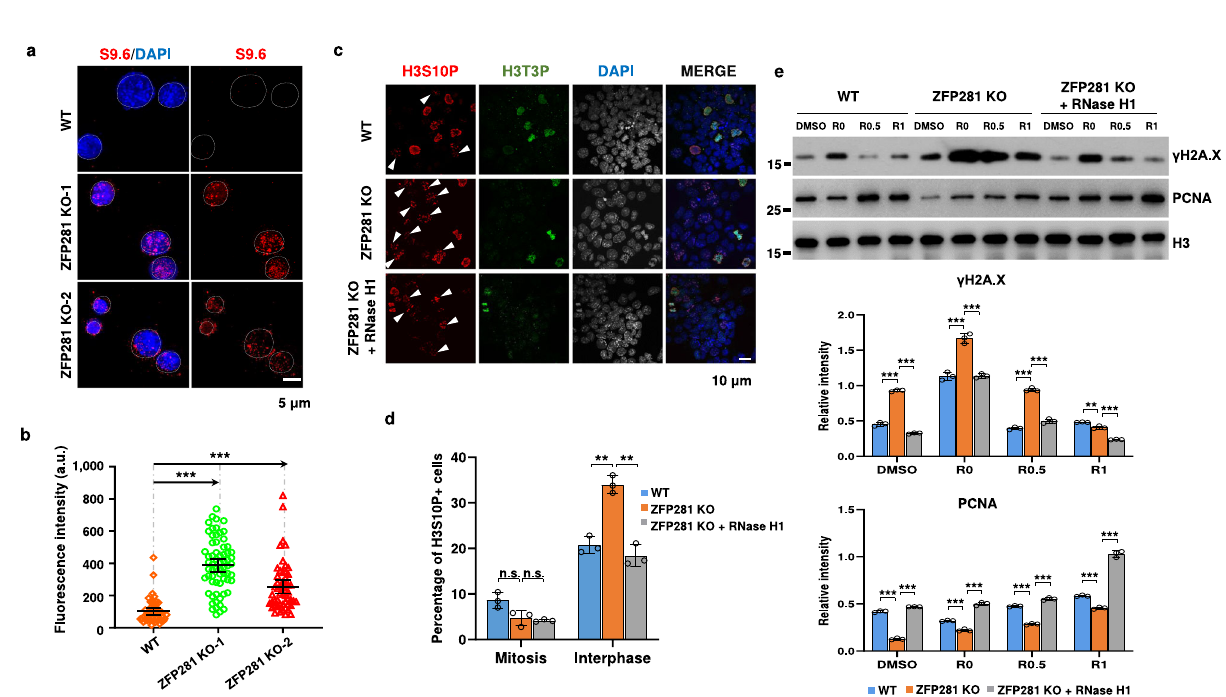
Fig. 3 ZFP281 depletion leads to aberrant R-loop accumulation. a Representative immuno fl uorescence images with the S9.6 antibody showing the levels of R-loop in WT, ZFP281 KO-1, and ZFP281 KO-2 ES cells. DNA was counterstained using DAPI. Three independent experiments show similar results. b Fluorescence intensities of R-loop loci in WT ( n = 48), ZFP281 KO-1 ( n = 66) and ZFP281 KO-2 ( n = 53) ES cells. Three independent experiments show similar results. Error bars represent 95% con fi dence intervals. Two-tailed, unpaired Student ’ s t tests were performed. (WT vs. ZFP281 KO-1, p < 0.0001; WT vs. ZFP281 KO-2, p < 0.0001.) ∗ p < 0.05, ∗∗ p < 0.01, ∗∗∗ p < 0.001, n.s. = not signi fi cant. c Immuno fl uorescence imaging of H3S10P and H3T3P in WT, ZFP281 KO, and ZFP281 KO with RNase H1 overexpression ES cells. White arrows showing the interphase cells positive for H3S10P. d Percentage of WT (total n = 369), ZFP281 KO (total n = 380) and ZFP281 KO with RNase H1 overexpression (total n = 290) ES cells in mitosis and interphase. Mean ± SEM from three independent experiments. Two-tailed, unpaired Student ’ s t tests were performed. (Mitosis, WT vs. ZFP281 KO, p = 0.0574; ZFP281 KO vs. ZFP281 KO + RNase H1, p = 0.5526. Interphase, WT vs. ZFP281 KO, p = 0.0020; ZFP281 KO vs. ZFP281 KO + RNase H1, p = 0.0016.) ∗ p < 0.05, ∗∗ p < 0.01, ∗∗∗ p < 0.001, n.s. = not signi fi cant. e Western blot analysis (upper panel) showing the levels of chromatin-bound γ H2A.X and PCNA in WT, ZFP281 KO, and ZFP281 KO with RNase H1 overexpression ES cells after release from APH treatment for 0, 0.5 and 1 h respectively. Histone H3 was used as a loading control. Gray values (middle and lower panels) of γ H2A.X and PCNA protein bands were determined by Image J and normalized to the loading control. Mean ± SEM from three independent experiments. Multiple t tests were performed. ( γ H2A.X in WT and ZFP281 KO, DMSO, p < 0.0001; R0, p = 0.0005; R0.5, p < 0.0001; R1, p = 0.0035. γ H2A.X in ZFP281 KO and ZFP281 KO + RNase H1, DMSO, p < 0.0001; R0, p = 0.0003; R0.5, p < 0.0001; R1, p = 0.0001. PCNA in WT and ZFP281 KO, DMSO, p < 0.0001; R0, p = 0.0002; R0.5, p < 0.0001; R1, p < 0.0001. PCNA in ZFP281 KO and ZFP281 KO + RNase H1, DMSO, p < 0.0001; R0, p < 0.0001; R0.5, p < 0.0001; R1, p < 0.0001.) ∗ p < 0.05, ∗∗ p < 0.01, ∗∗∗ p < 0.001, n.s. = not signi fi cant.